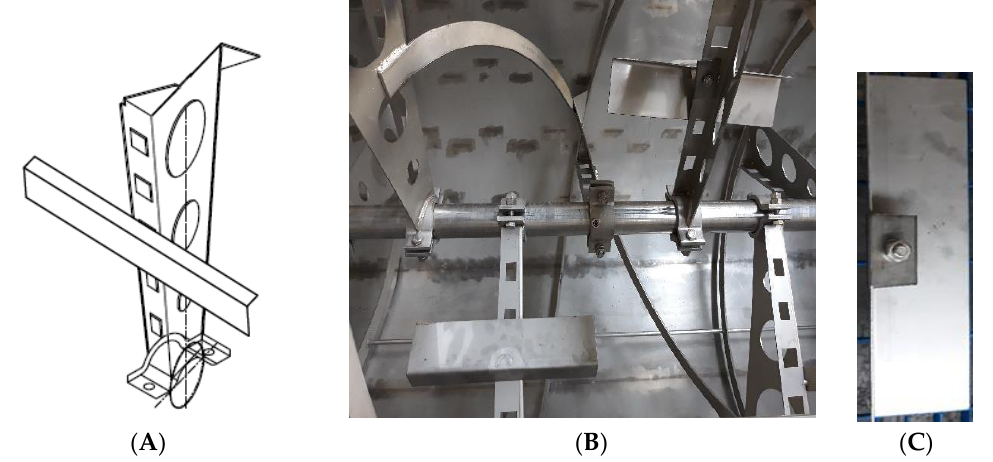
Figure 2. Details of the modified reel ( A ) Isometric view of the modified radial element of the reel, ( B ) malaxer tank equipped with modified reel and ( C ) the rectangular shaker element mounted on the radial elements.